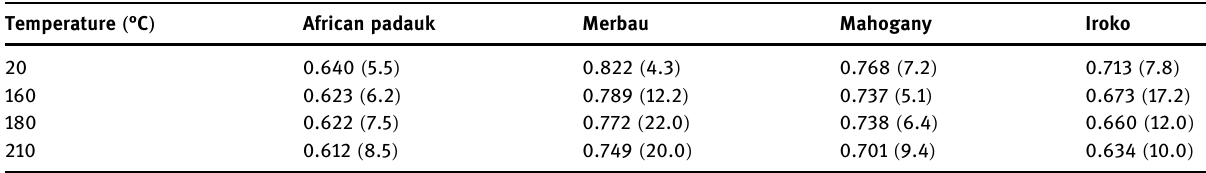
Table 4: Wood density before and after thermal modi fi cation ( g · cm − 3